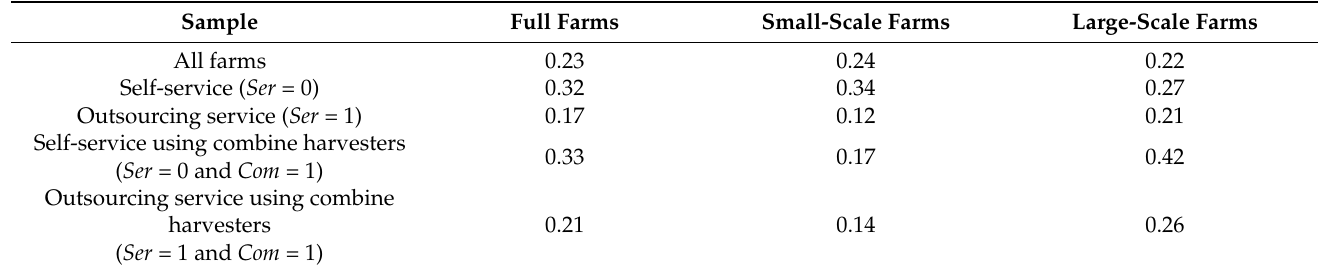
Table 1. Average work attitude of